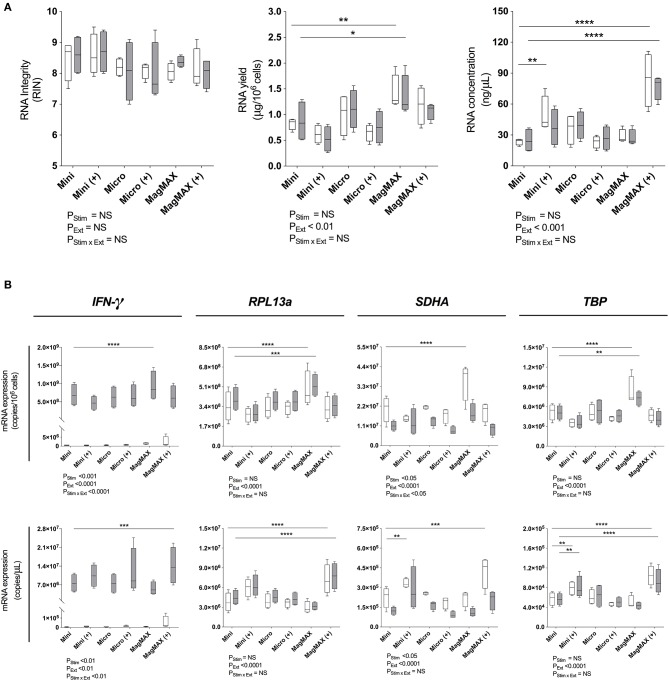
RNA extraction evaluation. (A) Bioanalyser analysis of RNA Integritry Number (RIN), and nanospectrophotometer analysis of yield and concentration were obtained using three commercially-available extraction kits with (+) or without post-extraction RNA purification and concentration. (B) RT-qPCR analysis of IFN-γ, RPL13a, SDHA, and TBP expression normalized to cell number (copies/106 cells) or cDNA concentration (copies/μL). 1 × 106 PBMCs paired samples were cultured with complete media (white) or PMA/Iono (gray) for 6 h. RNA was extracted using the RNeasy® Mini (Mini) Kit, RNeasy® Micro (Micro) Kit (both QIAGEN), or MagMAX™ mirVana™ (MagMAX) Total RNA Isolation Kit (Applied Biosystems), with concentration step performed using the RNeasy® MiniElute Cleanup Kit (QIAGEN). All samples were reverse transcribed with Superscript™ III (Invitrogen). Data were analyzed using a two-way ANOVA with post-hoc Bonferroni's multiple-comparisons test (*P ≤ 0.05; **P ≤ 0.01; ***P ≤ 0.001; ****P ≤ 0.0001). Biological replicate (n = 4), triplicate RNA extractions, with single reverse transcription reactions per extraction were performed. Sample mean calculated from the mean of the technical RNA extractions which were in turn calculated from the mean of the technical triplicate qPCR reactions. Biological mean ± biological SEM are shown.